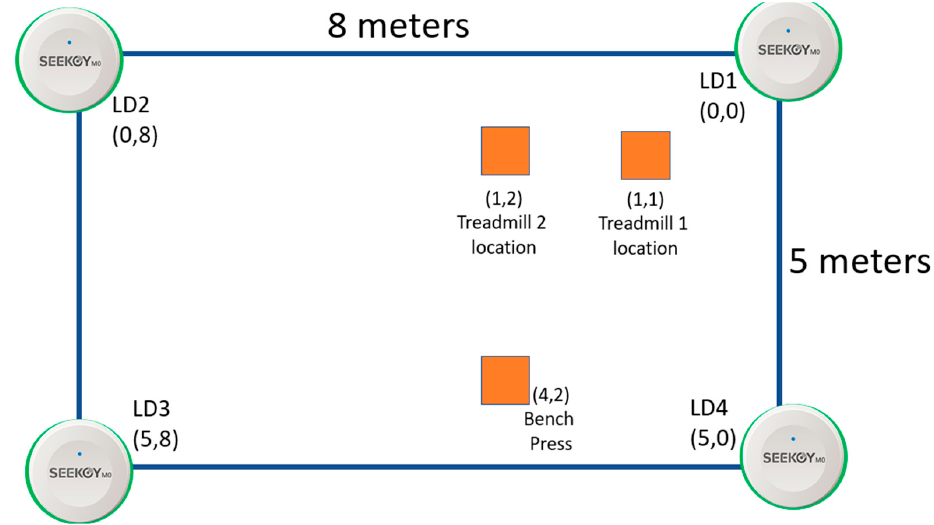
Figure 10. The locations of LDs and gym equipment in the experimental area coordinate system.